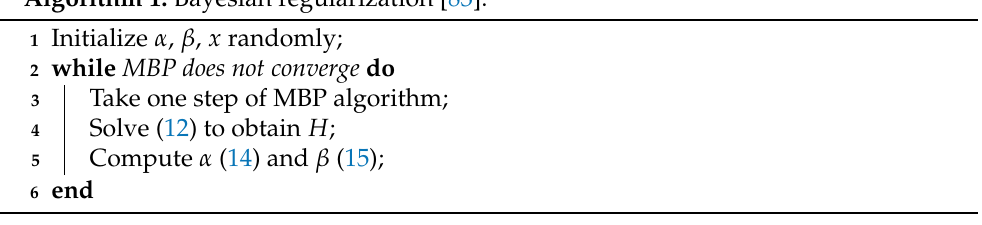
Algorithm 1: Bayesian regularization [83].